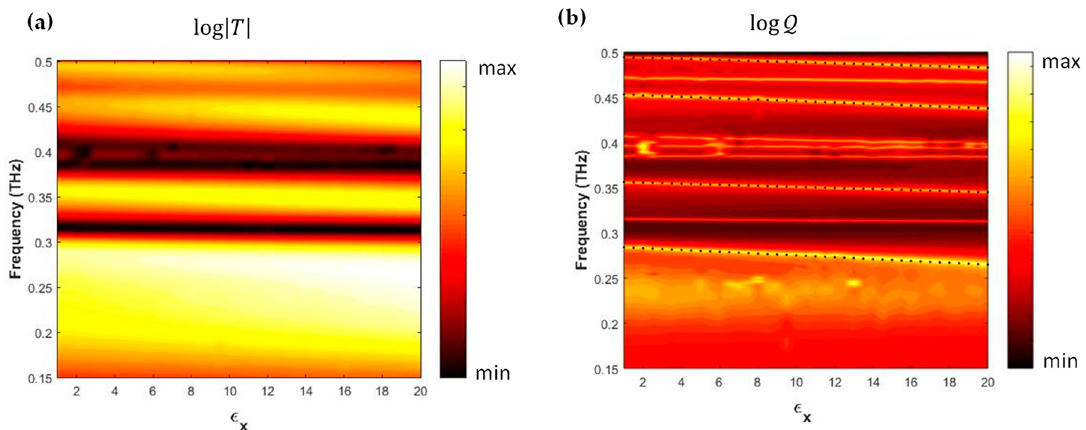
Figure 4. ( a ) False color map (log scale) of the transmission T(f, ε x ) for the capped metagrid. ( b ) Same ( 2 ) for 𝒬 (cid:3021)((cid:2870)) (𝑓, 𝜀 (cid:3051) ) . Dotted lines highlight the behavior of 𝑓 (cid:2869)–(cid:2872) (𝜀 (cid:3051) ) , selected as the most sensitive modes for Q T in the CMG structure.